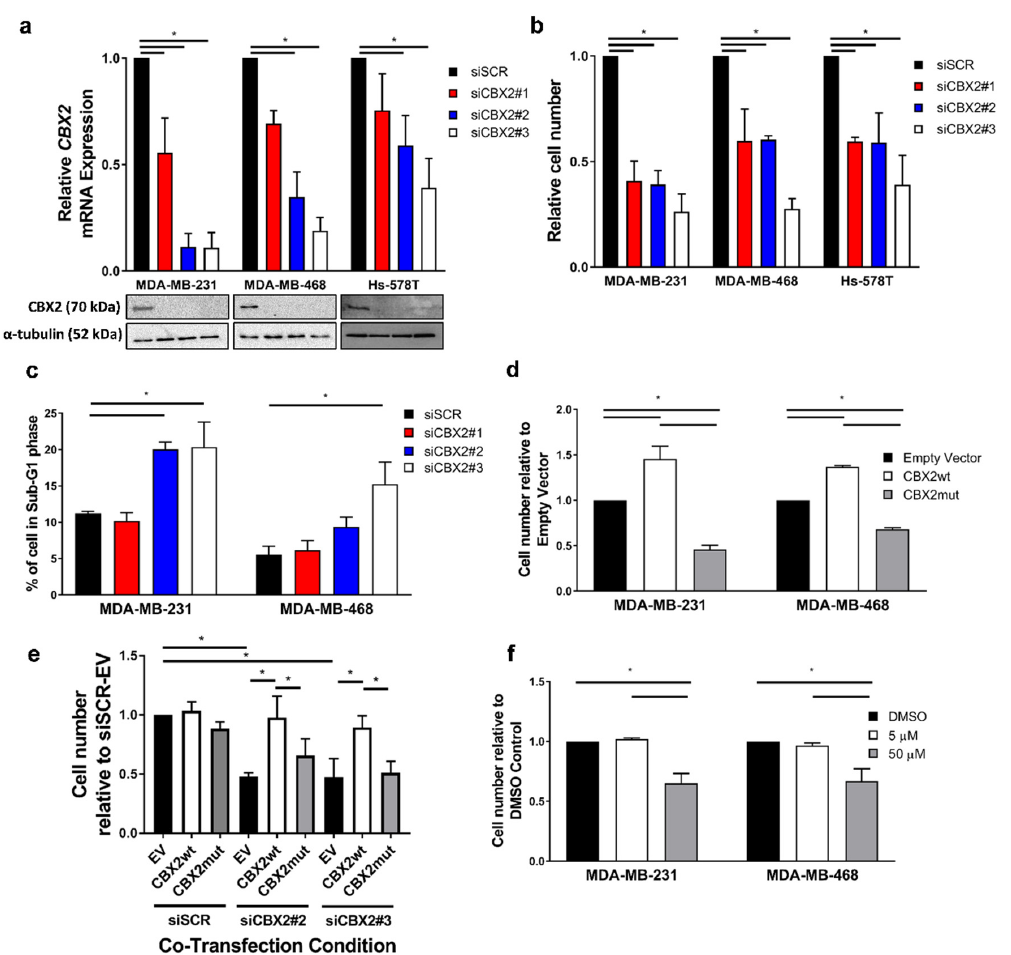
Figure 1.– CBX2 chromatin interactions are required for TNBC cell growth/viability. MDA ‐ MB ‐ 231, MDA ‐ MB ‐ 468 and Hs578T cells were transfected with either a non ‐ silencing siRNA control (siSCR) or one of 3 CBX2 targeting siRNAs (siCBX2#1/#2/#3). Cells were cultured for 72 h, followed by: gene and protein expression analysis ( a ), cell growth analysis ( b ) and cell cycle analysis ( c ). ( a ) CBX2 gene and protein expression was assessed by qPCR and Western blot, respectively. α‐ tubulin protein ex ‐ pression was assessed to compare protein loading between samples. Lanes on the Western blot im ‐ ages align with the cell line and experimental arm indicated in the graph above. CBX2 gene expres ‐ sion data are the mean of 3 repeats ± SEM and are expressed relative to CBX2 expression in siSCR transfected cells. ( b ) Cell growth was assessed by cell counts. Cell count data are the mean of 3 repeats ± SEM and are expressed relative to cell counts for siSCR transfected cells. ( c ) The effect of CBX2 knockdown on the cell cycle was assessed by propidium iodide flow cytometry. The % of cells in the sub ‐ G1 phase of the cell cycle is shown and is an average of 3 repeats ± SEM. ( d ) MDA ‐ MB ‐ 231 and MDA ‐ MB ‐ 468 cells were transfected with 1 μ g of either an empty vector control plasmid or a plasmid containing a wild ‐ type version of CBX2 (CBX2wt), or a chromodomain ‐ deficient mutant (CBX2mut), and grown for 72 h followed by cell counts. Cell count data are the mean of 3 repeats ± SEM and are expressed relative to cell counts for empty vector ‐ transfected cells. ( e ) MDA ‐ MB ‐ 231 cells were co ‐ transfected with combinations of siSCR, siCBX2#2/3 and empty vector (EV) or CBX2wt/mut plasmids and grown for 72 h followed by cell counts. Cell count data are the mean of 3 repeats ± SEM and are expressed relative to cell counts for siSCR and empty vector co ‐ transfected cells. ( f ) MDA ‐ MB ‐ 231 and MDA ‐ MB ‐ 468 cells were treated with a DMSO control or 5 and 50 μ M of SW2_ 152F and grown for 72 h (MDA ‐ MB ‐ 231) or 96 h (MDA ‐ MB ‐ 468) followed by cell counts. Cell count data are the mean of 3 repeats ± SEM and are expressed relative to cell counts in the DMSO control arms of the experiment. In all experiments p ‐ values were determined by Turkey’s multiple comparisons test (* denotes p <